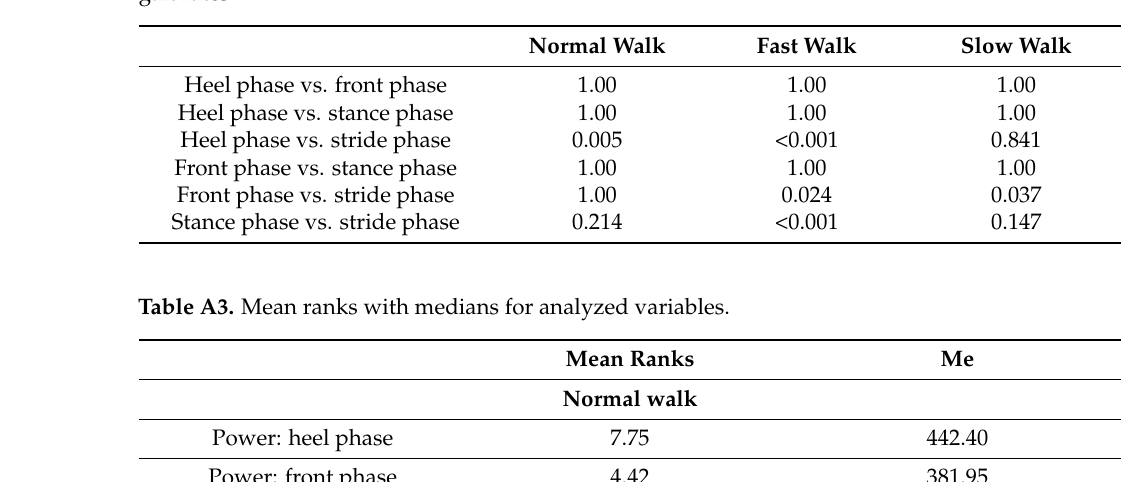
Table A2. Results of post hoc tests: the differences between the power values measured for different gait rates.